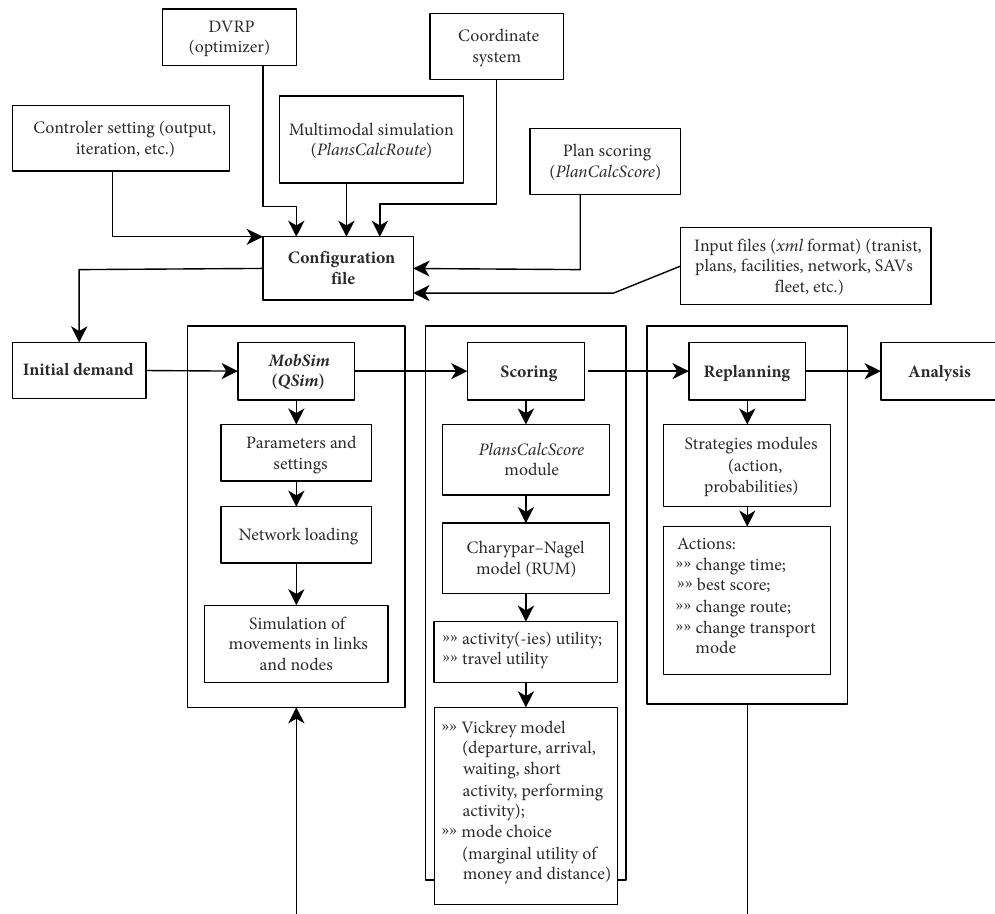
Figure 3. Data analysis flow